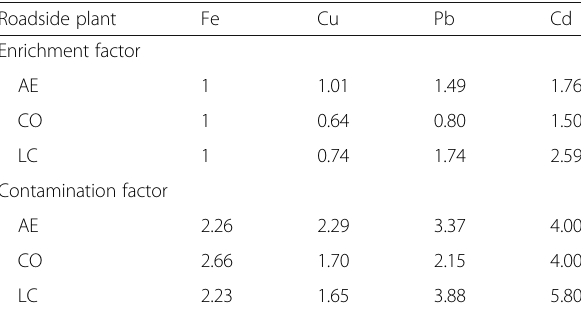
Table 3 Enrichment factor (EF) and contamination factor